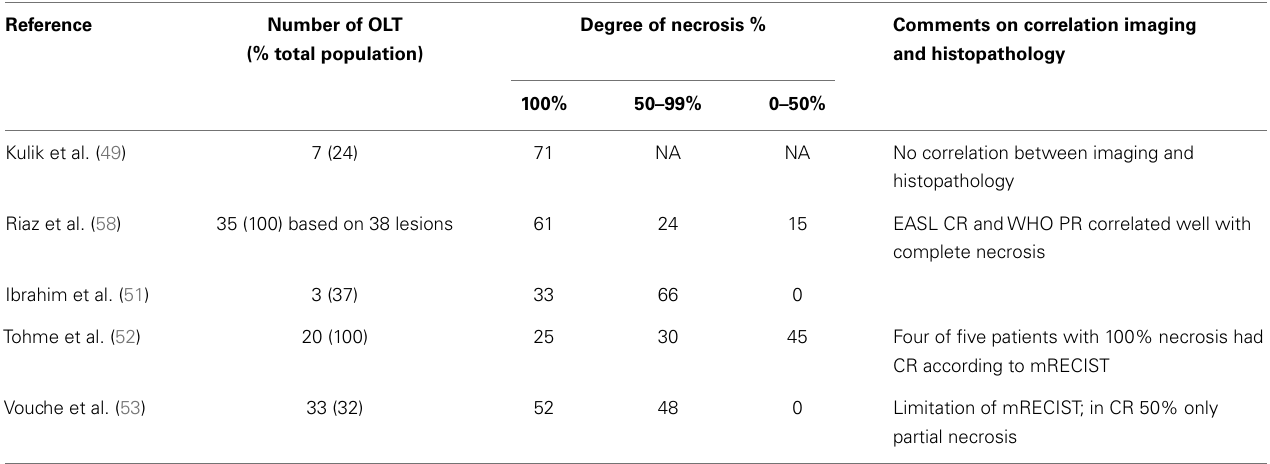
Table 3 | Explanted data of HCC patients